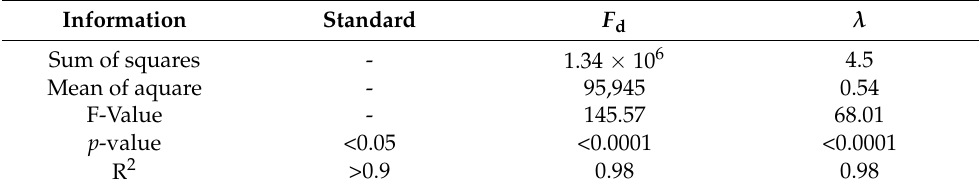
Table 6. Variance analysis. Table 6. Variance